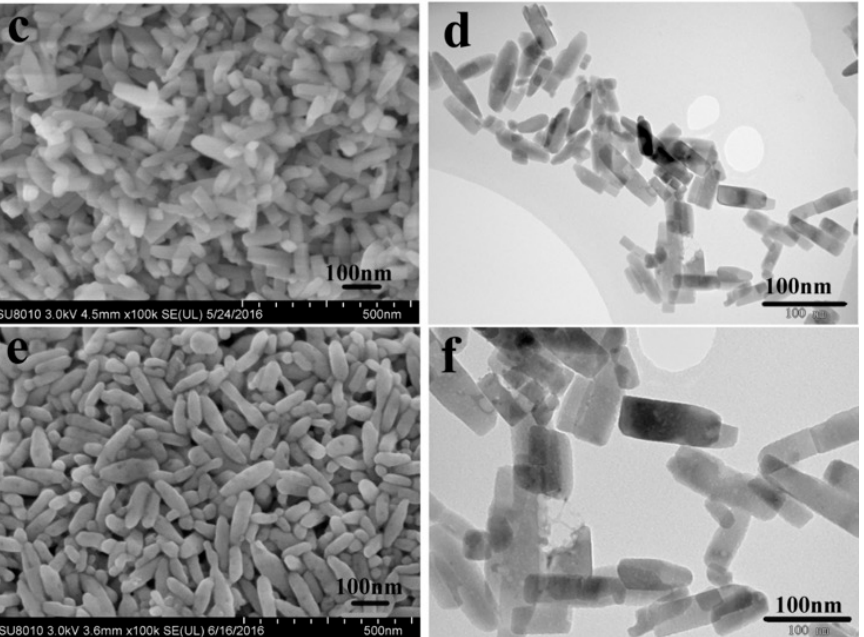
Figure 4. SEM and TEM images of the prepared samples: ( a , b ) precursor; ( c , d ) LMP; and ( e , f ) LMP/C.